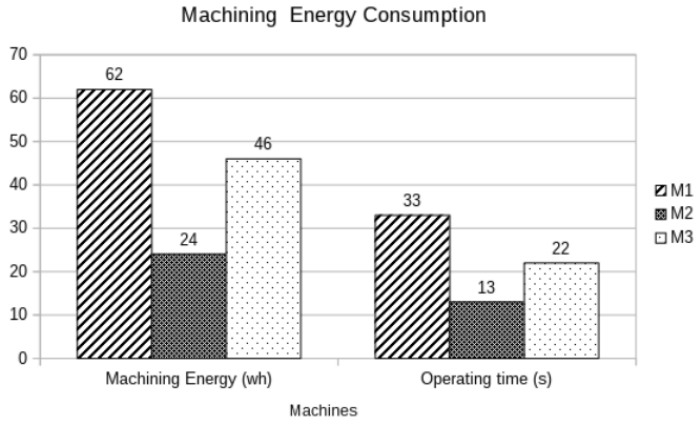
Figure 12. Profiling of the machine energy consumption of the predictive solution.